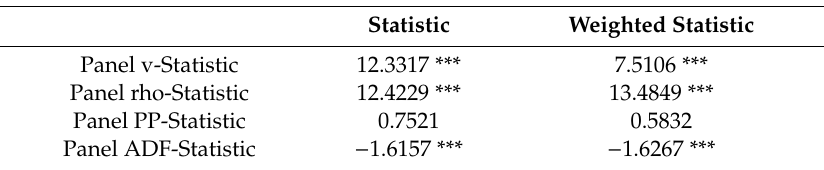
Table 4. Panel cointegration test.